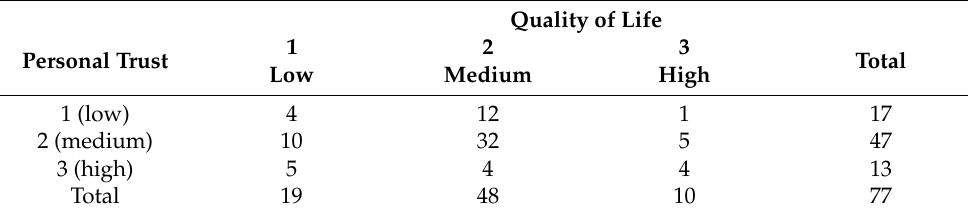
Table 2. Distribution of districts into groups in the Czech Republic according to the average values of the quality-of-life index and the personal trust index.